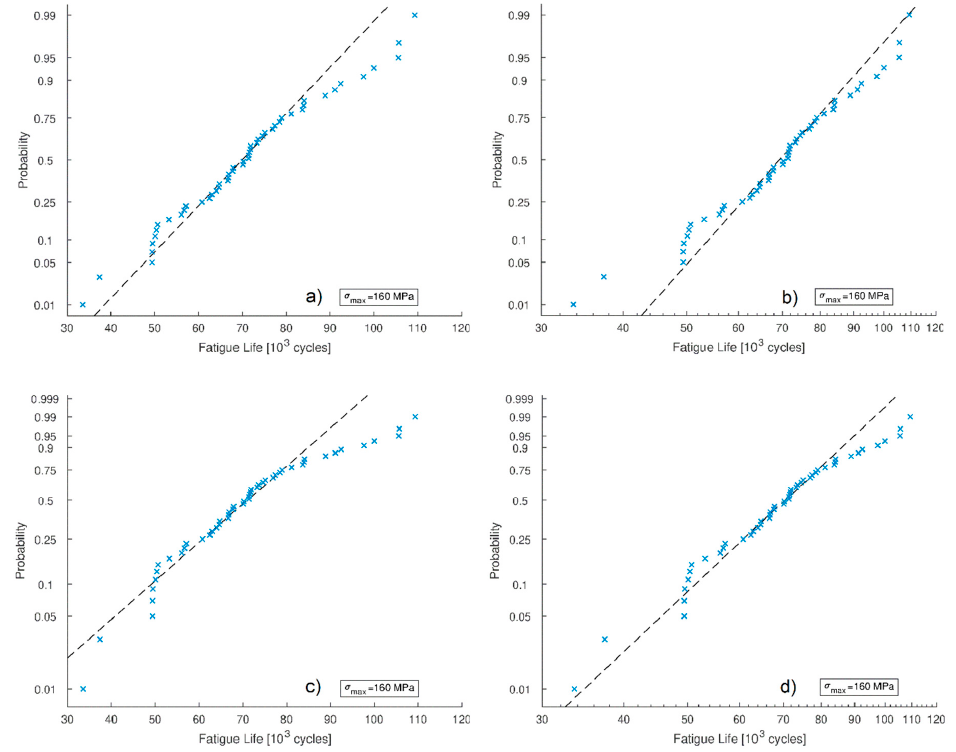
Figure 10. Fatigue life at 160 MPa: probability plots for normal ( a ), log-normal ( b ), extreme value ( c ) and Weibull ( d ) distributions.